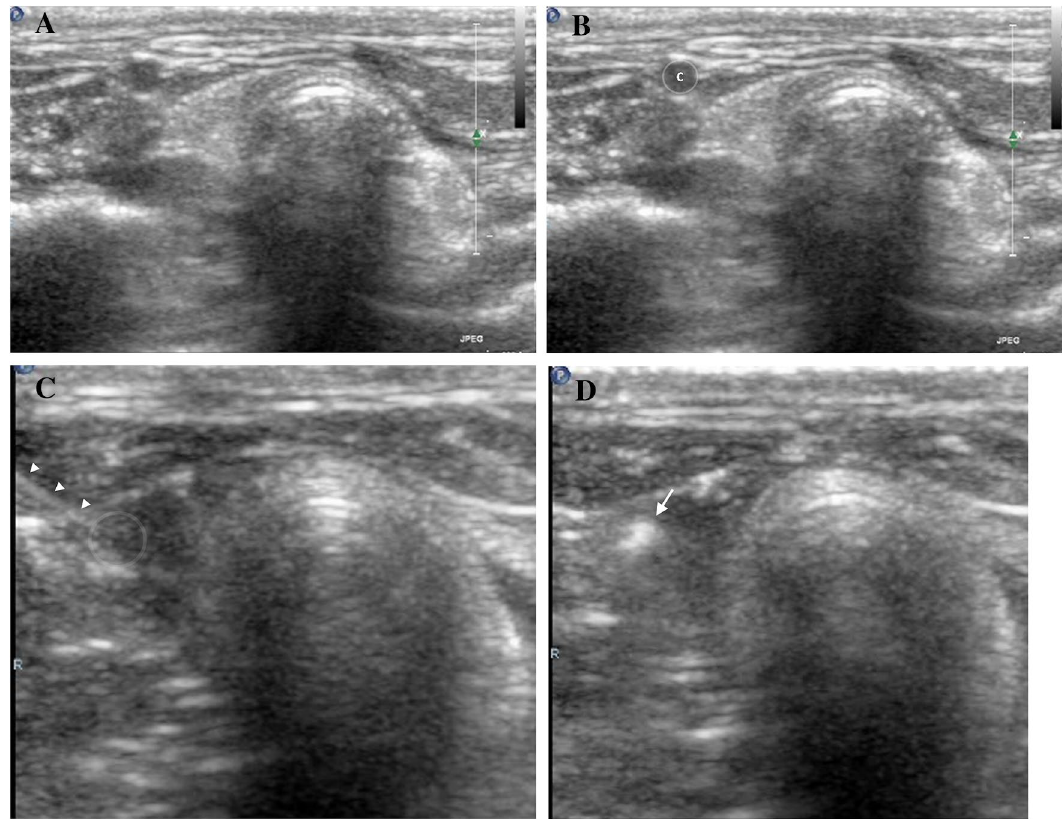
Figure 1. Puncture of the carotid artery and administration of the embolic agent. ( A , B ) The right common carotid artery (letter “C”) of the rabbit before puncture. ( C ) Puncture of the carotid artery with 23-gauge winged infusion set needle (arrowheads). ( D ) Monitoring of the embolic agent (arrow)